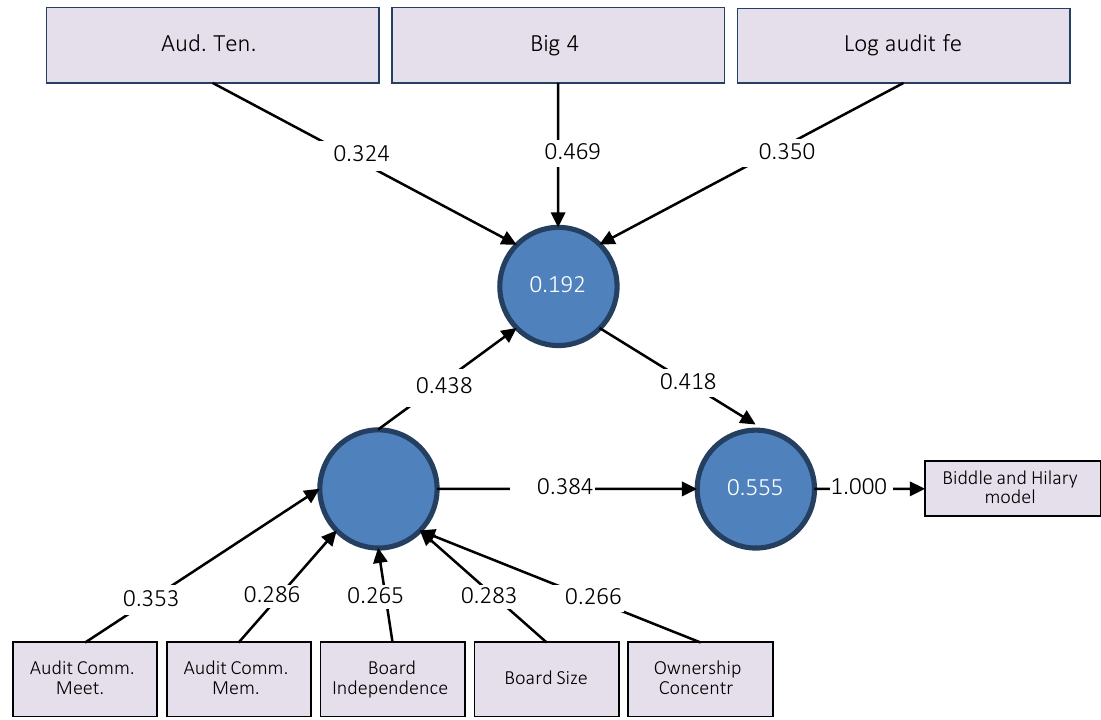
Figure 3. Structural model (outer model), UNDERINV model